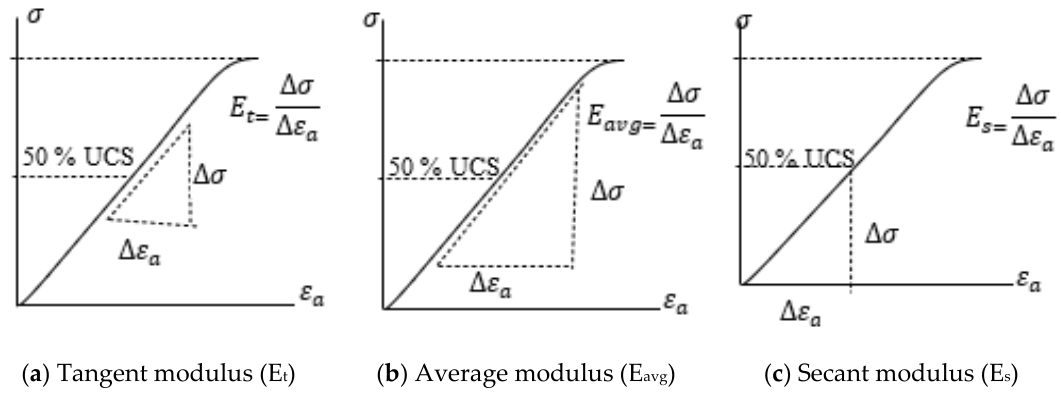
Figure 7. The method used to determined Young’s modulus at 50% UCS [7].